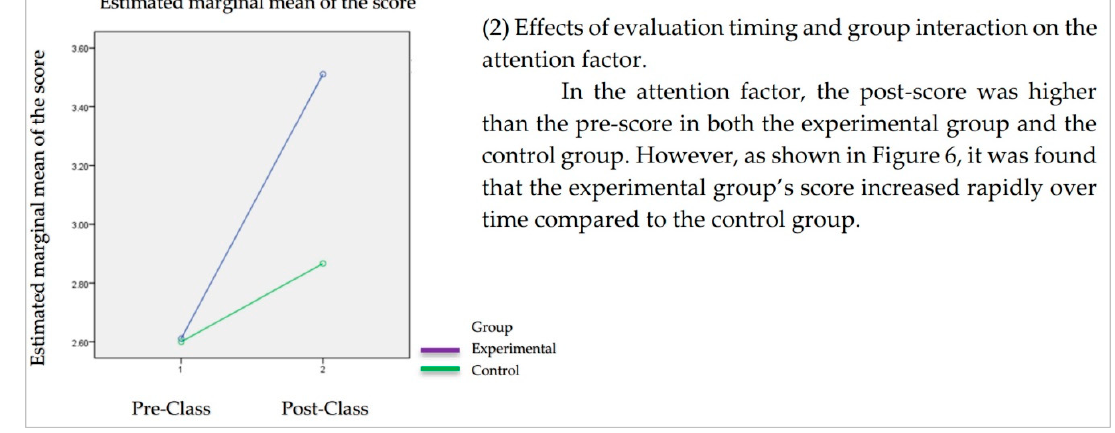
Figure 6. Effect of timing and group interaction on Attention. Figure 6. E ff ect of timing and group interaction on